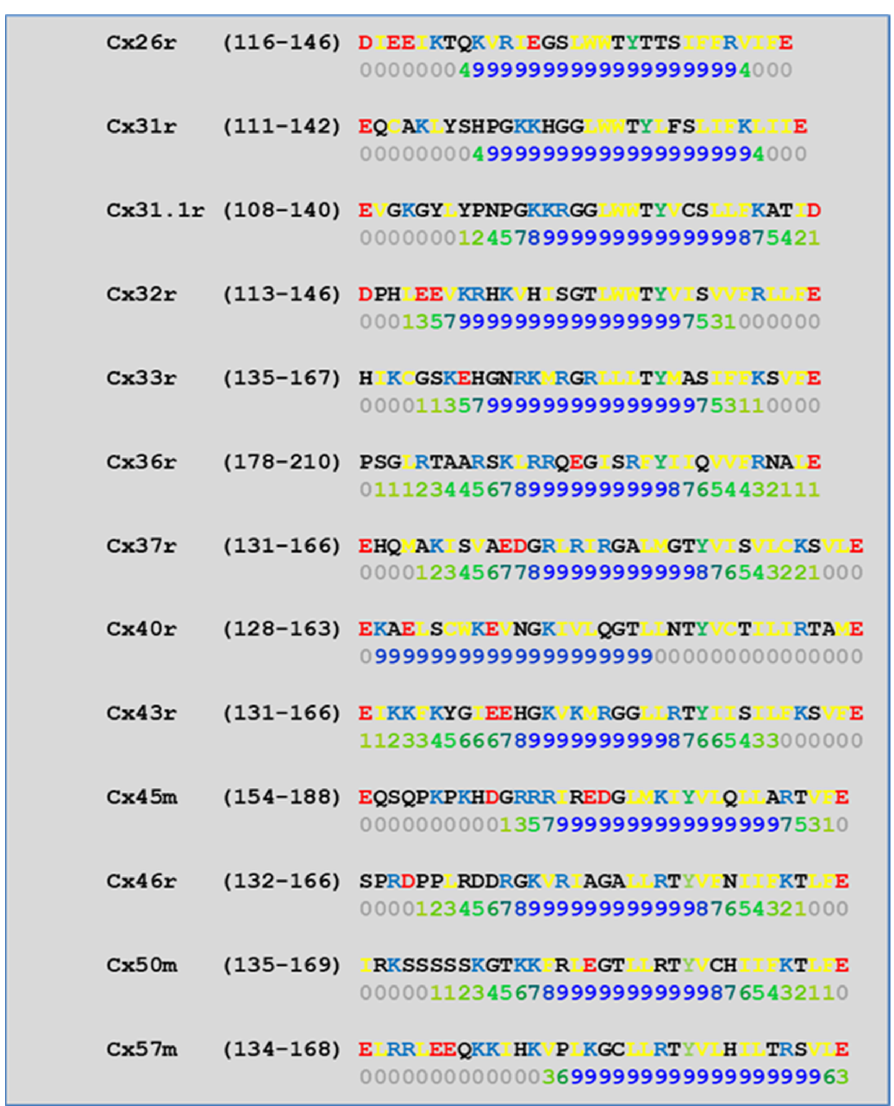
Figure 8. Predicted CaM-binding Site at CL2 domain. Our data indicating that CL2 contains a domain relevant for chemical gating [108] were first confirmed by the evidence for the presence of a CaM binding site in CL2 of Cx43